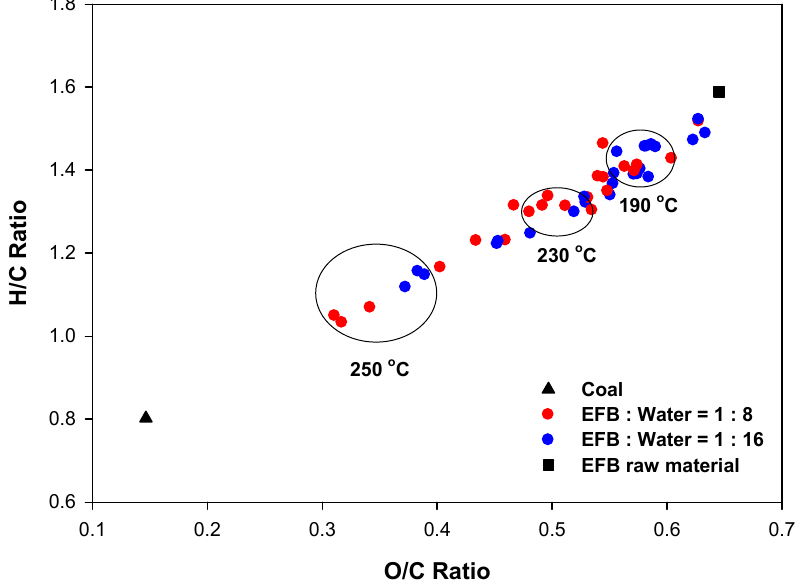
Figure 5. O/C and H/C ratios of EFB according to the reaction temperature and water content.